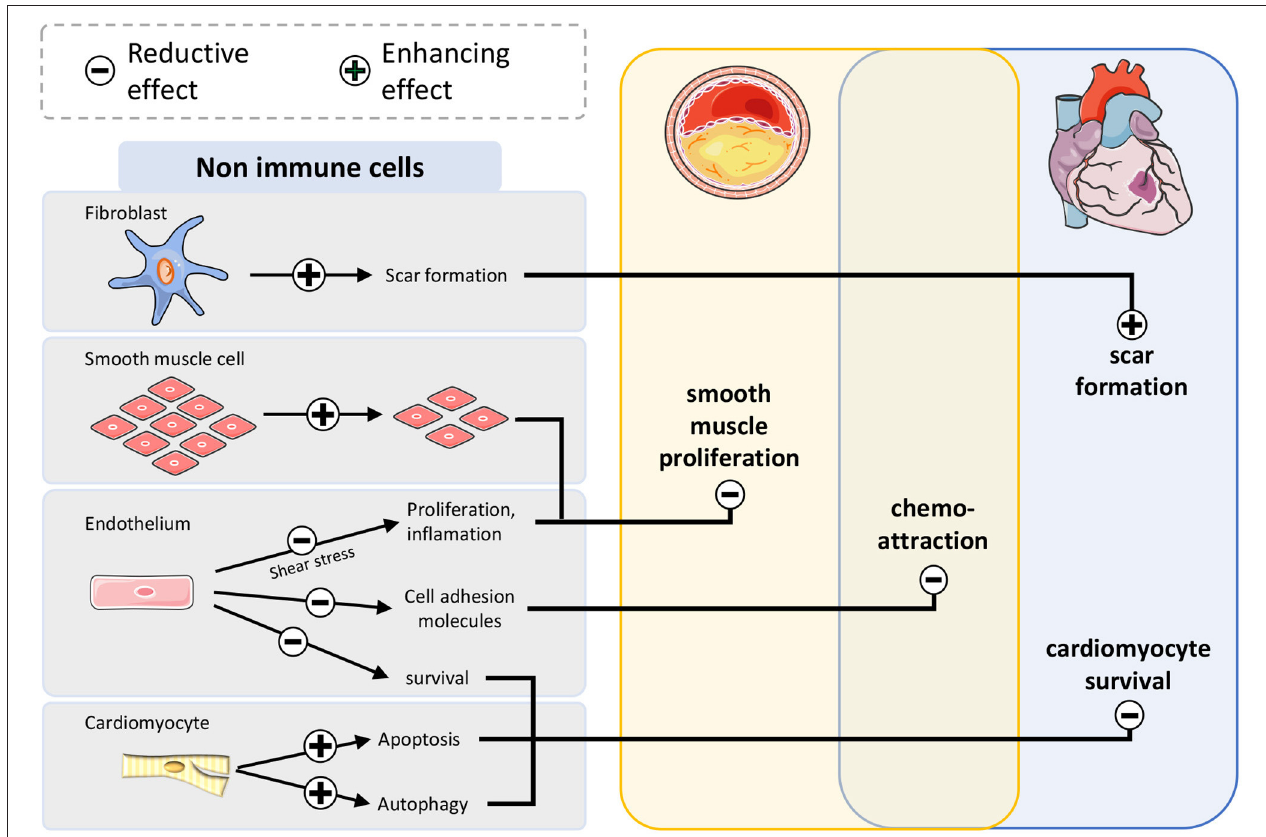
FIGURE 3 | mTOR-inhibition affects atherosclerosis and myocardial infarction by modulation of non-immune cells. Smooth muscle cells proliferate less after mTOR inhibition leading to restrained plaque growth. Survival of endothelium and cardiomyocytes after infarction is impaired, leading to larger infarct size. Suppressive fibroblasts improve scar formation stabilizing the wound after myocardial infarction.